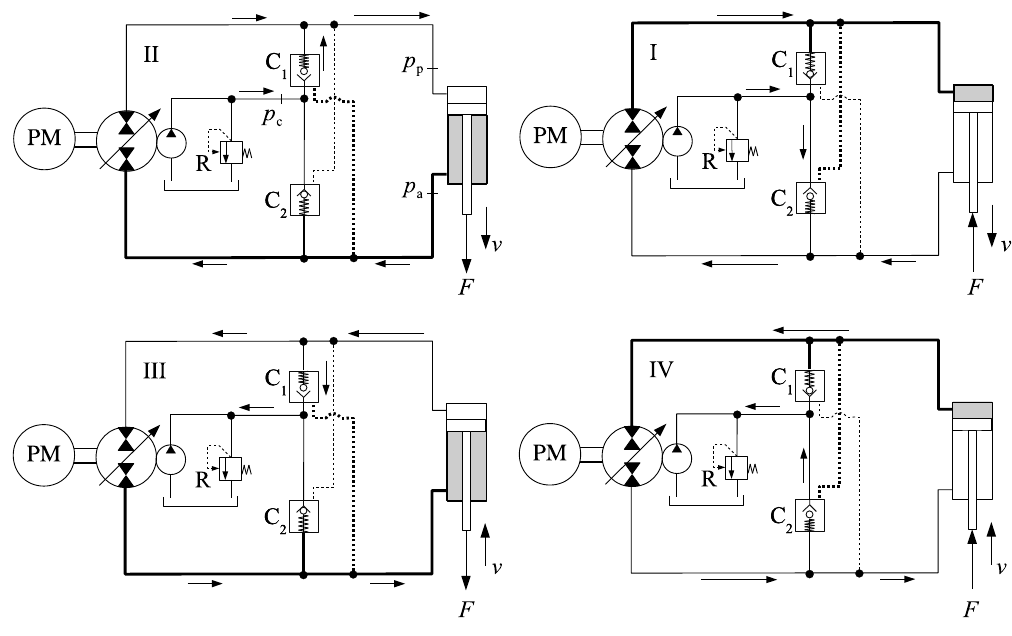
Figure 6. Circuit with piloted check valves.